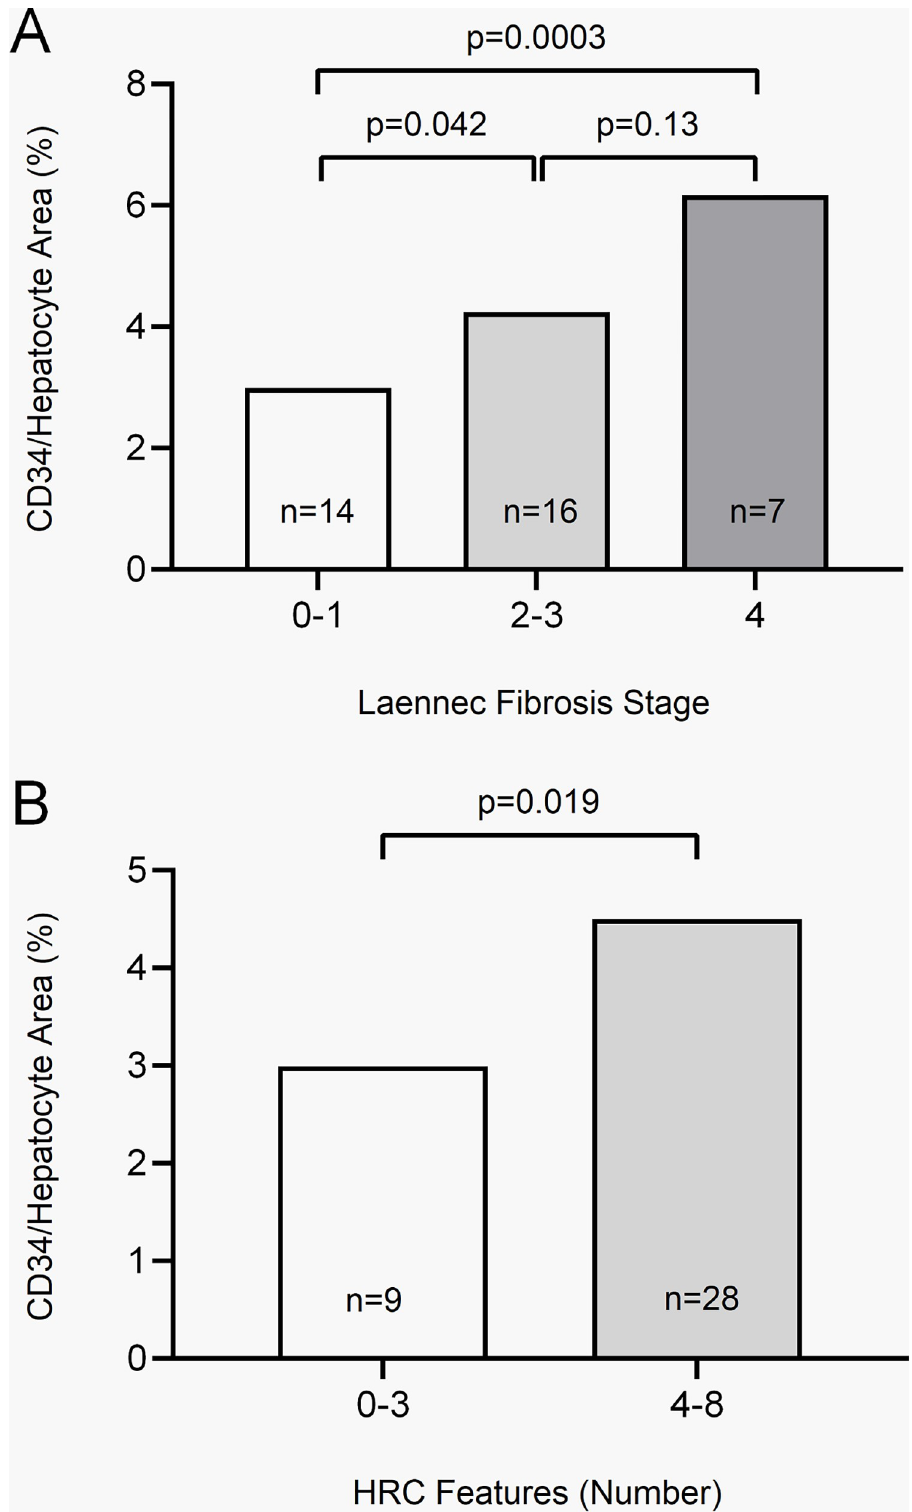
Fig 2. Relationship of CD34 expression to hepatocyte area by fibrosis and regression features. CD34 expression area relative to hepatocyte area based on Laennec fibrosis stage (A); CD34 expression area relative to hepatocyte area based on number of HRC features